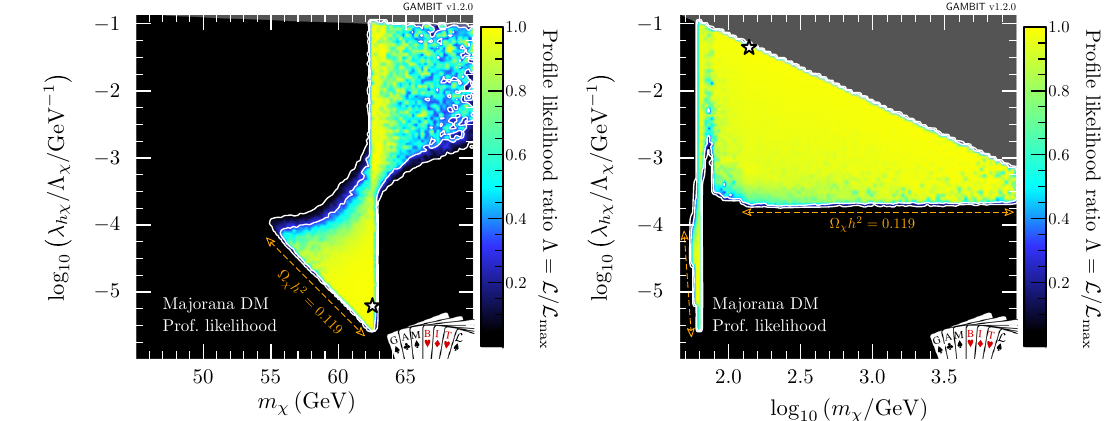
Fig. 3 Profile likelihood in the ( m χ ,λ h χ /Λ χ ) plane for Majorana fermion DM. Contour lines show the 1 and 2 σ confidence regions. The left panel gives an enhanced view of the resonance region around m χ ∼ m h / 2. The right panel shows the full parameter space explored in our fits. The greyed out region shows where our approximate bound